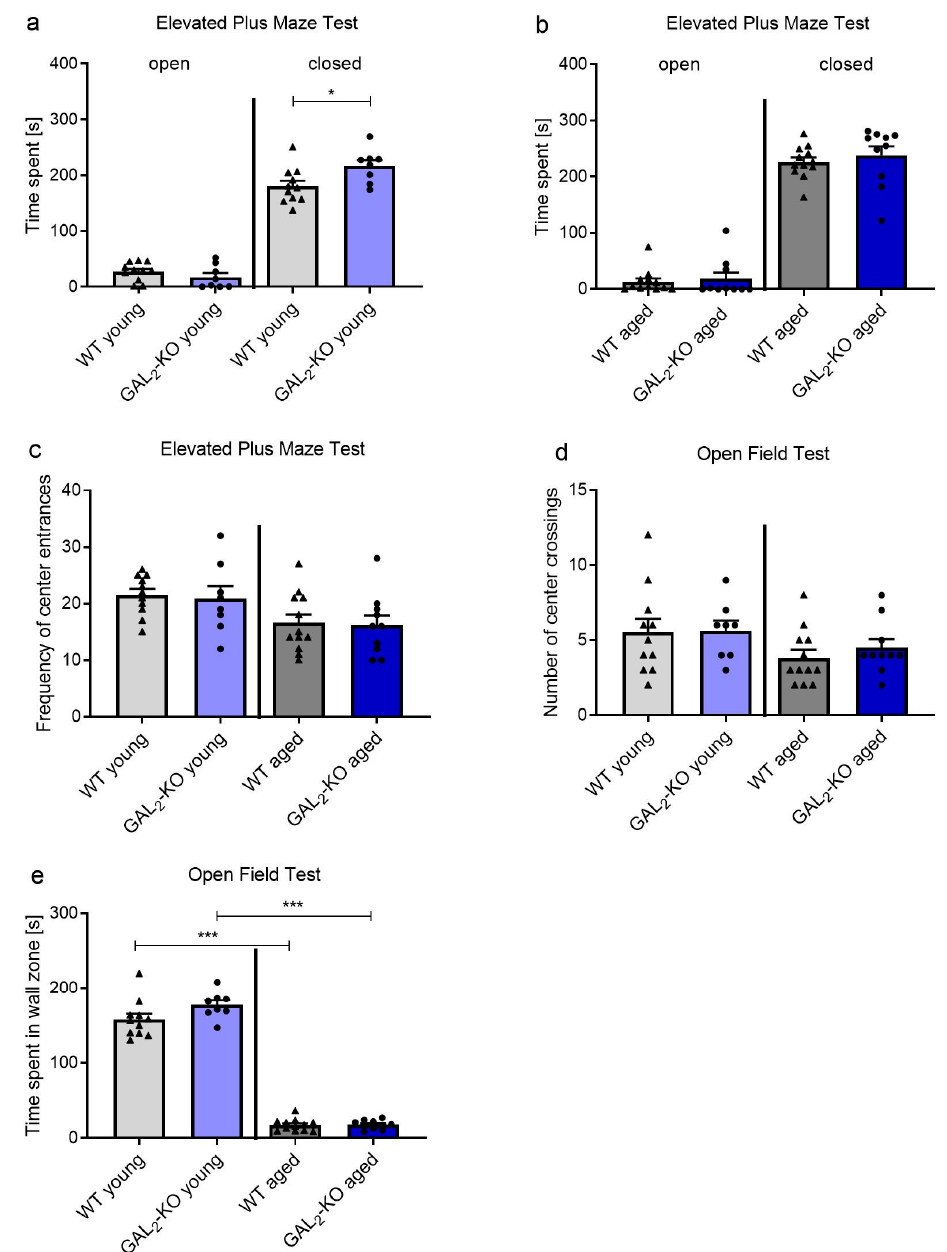
Figure 2. Behavior of GAL 2 -KO and WT mice in ( a – c ) EPM and ( d , e ) OF tests. Time spent in the open and closed arms of the EPM in ( a ) 3-month-old (young) and ( b ) 12–14-month-old mice (aged). ( c ) Frequency of center entrances in the EPM in young and aged mice. ( d ) Number of center crossings and ( e ) time spent in the wall zone of the OF test in young and aged mice. Values are represented as mean ± SEM, n = 8–12 animals per group, * p < 0.05, *** p < 0.001. GAL 2 -KO: GAL 2 -knockout; WT: Wildtype; EPM: Elevated Plus Maze; OF: Open Field.